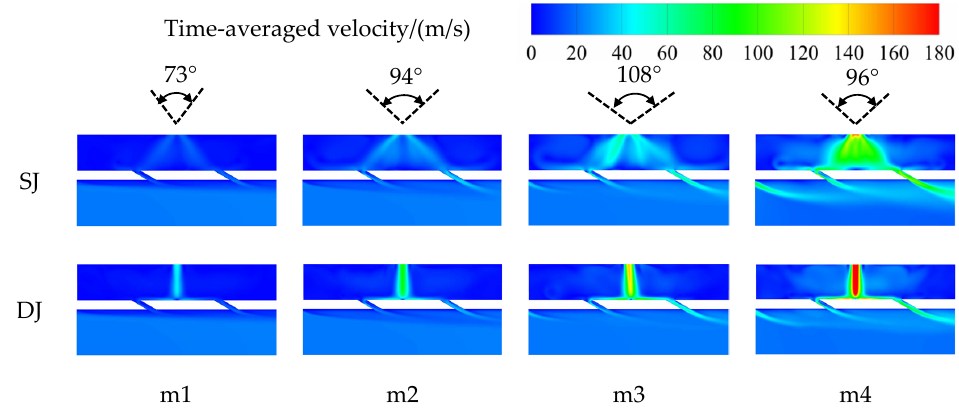
Figure 6. Time-averaged velocity magnitude (front view) for α = 30 ◦ at various mass flow Figure 6. Time ‐ averaged velocity magnitude (front view) for α = 30° at various mass flow rates. Table 3. The time ‐ averaged flow resistance coefficient of the coolant flow.